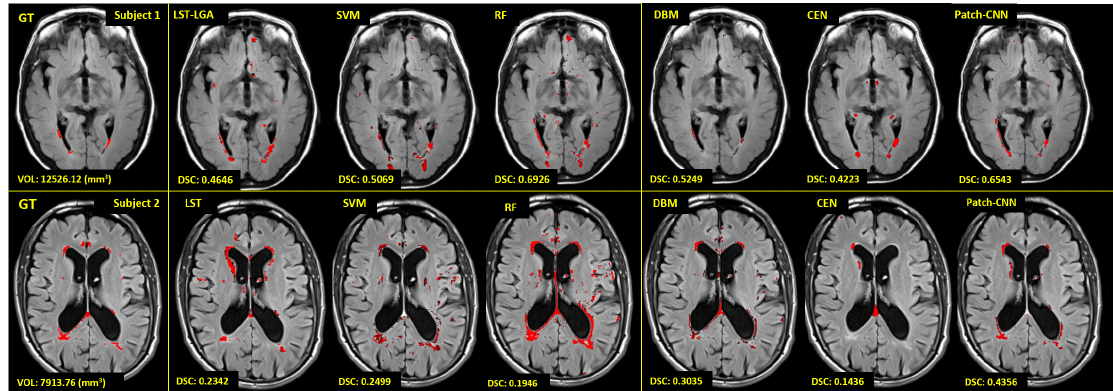
Figure 9. Visualisation of automatic WMH segmentation results from LST-LGA, SVM-SET3, RF-SET1, DBM, CEN and patch-CNN. Red regions are WMH labelled by experts (GT) or conventional/deep learning algorithms. We visualise two different subjects with very different WMH burden to see how the WMH volume affects the performance of conventional/deep learning algorithms. Volume of WMH and value of the DSC metric for each algorithm are at the bottom left on each respective